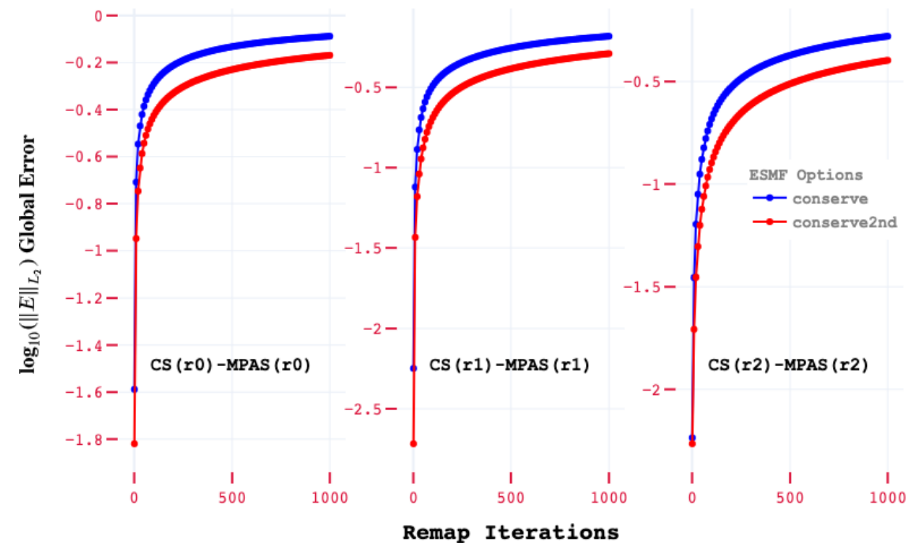
Figure 12. ESMF comparison of conserve and conserve2nd options for CS-MPAS RRMs for the TOPO field using log ( (cid:107) E (cid:107) L metrics as a function of N r